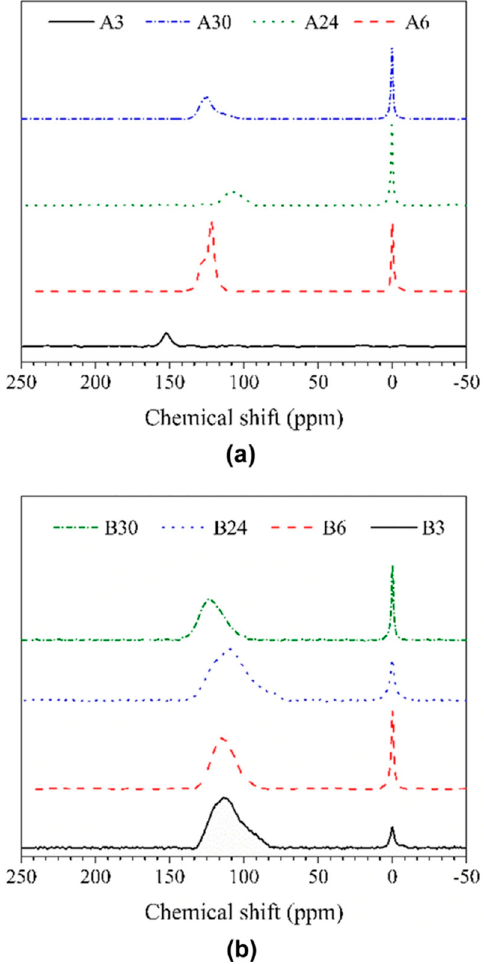
Figure 10. HP 129 Xe NMR spectra of hydrophobic silica gels synthesized with ( a ) acid catalysis and ( b ) basic catalysis. The numbers indicate the different aging times. Reprinted with permission from reference [108]. Copyright 2021 Journal of Sol ‐ Gel Science and Technology .